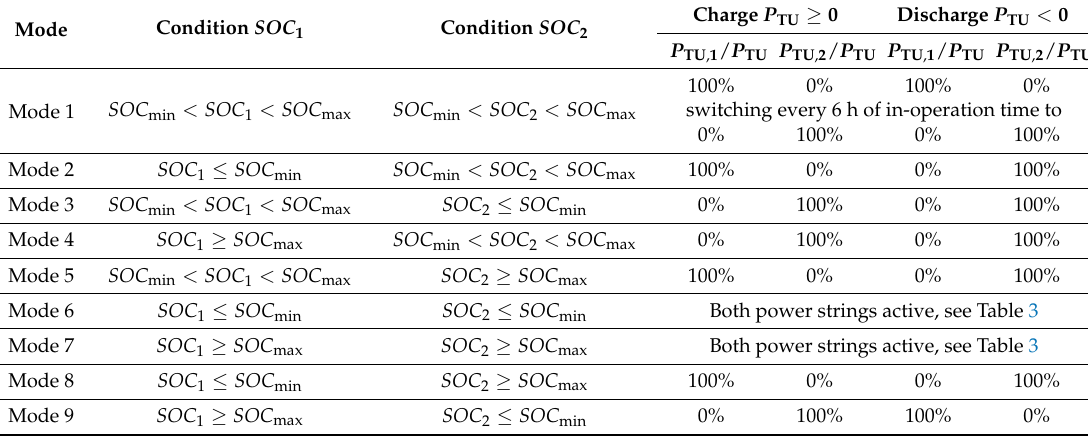
Table 4. Operation modes for optimized Power Flow Distribution Strategy for operating points theoretically requiring only a single power string ( | P TU | ≤ P TU,String,max